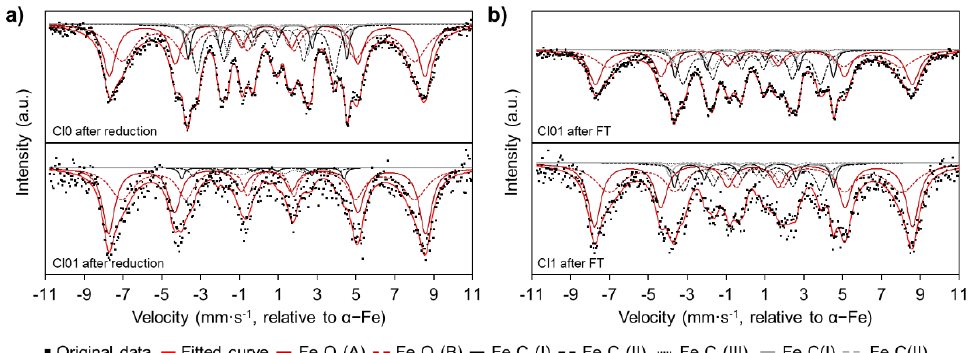
Figure 5. Mössbauer spectra of precipitated iron catalysts with chlorine after ( a ) reduction and ( b ) Fischer – Tropsch synthesis reaction.